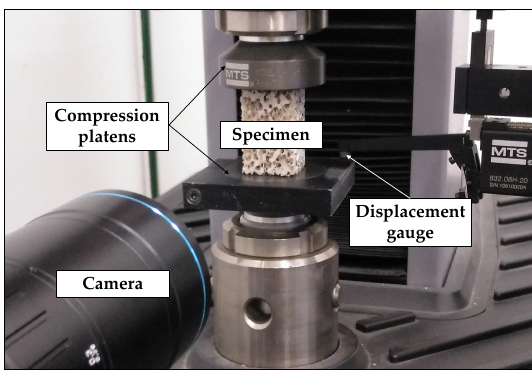
Figure 2. Set up used for open-cell polyurethane foams compression testing. A displacement gauge is used to measure the relative displacement of compression platens avoiding any compliance effect. A camera is positioned perpendicular to the specimen to acquire images during testing.